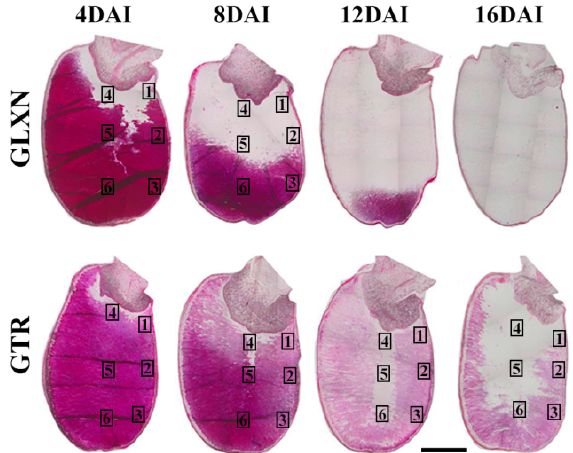
Figure 6. The longitudinal section of the whole kernel during seedling growth. The section is stained with Schiff ′ s reagent. Scale bar = 2 mm.